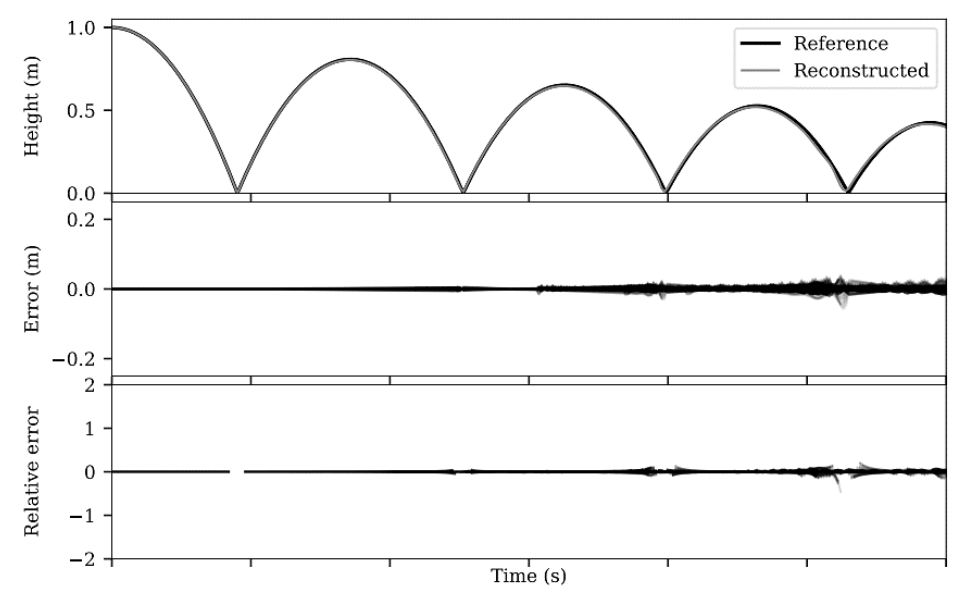
Figure 4. Reconstruction performance of a dimension 1 AAM when only the coefficient of restitution varies; Same graphical convention as in Figure 2